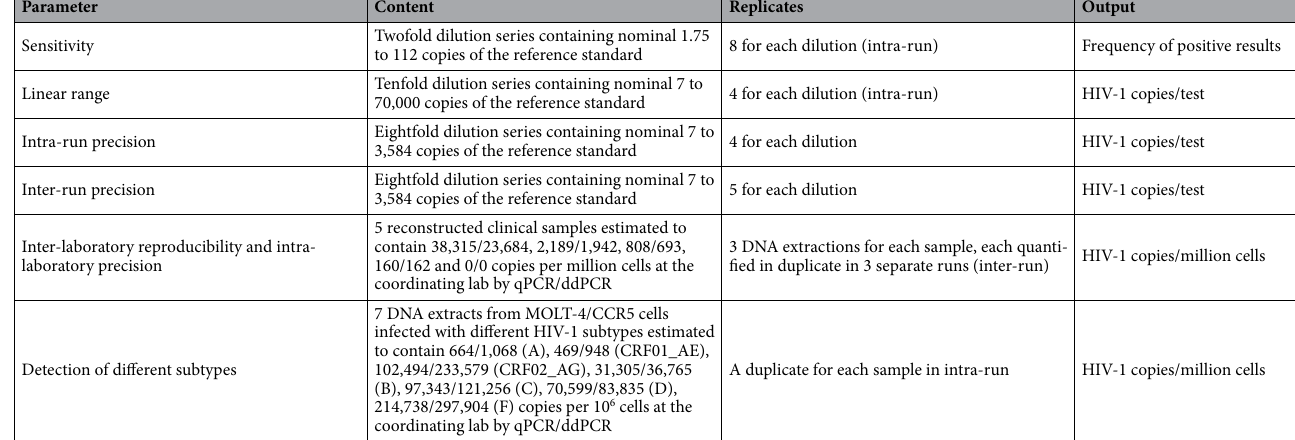
Supplementary Table 1. At individual sample level, fold-difference values were comparable across labs using